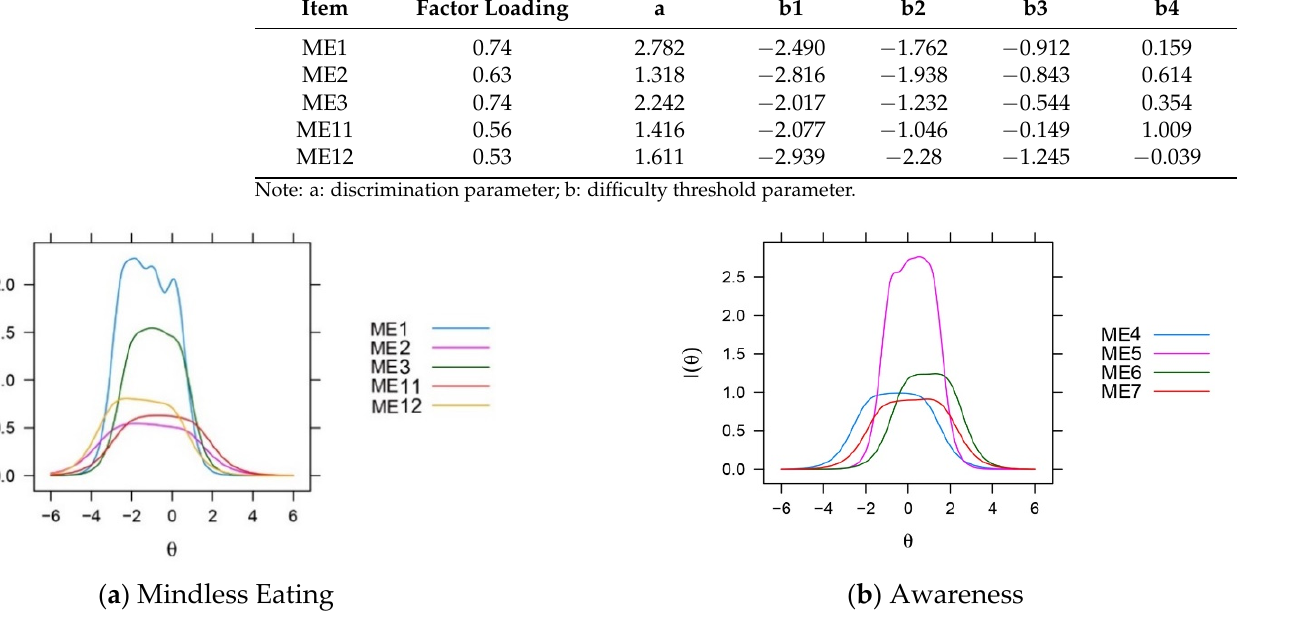
Figure A2. Function information trace line of Mindless Eating and Awareness subscales. ( a ) Item function trace of Mindless Eating subscale. ( b ) Item function trace of Awareness subscale.